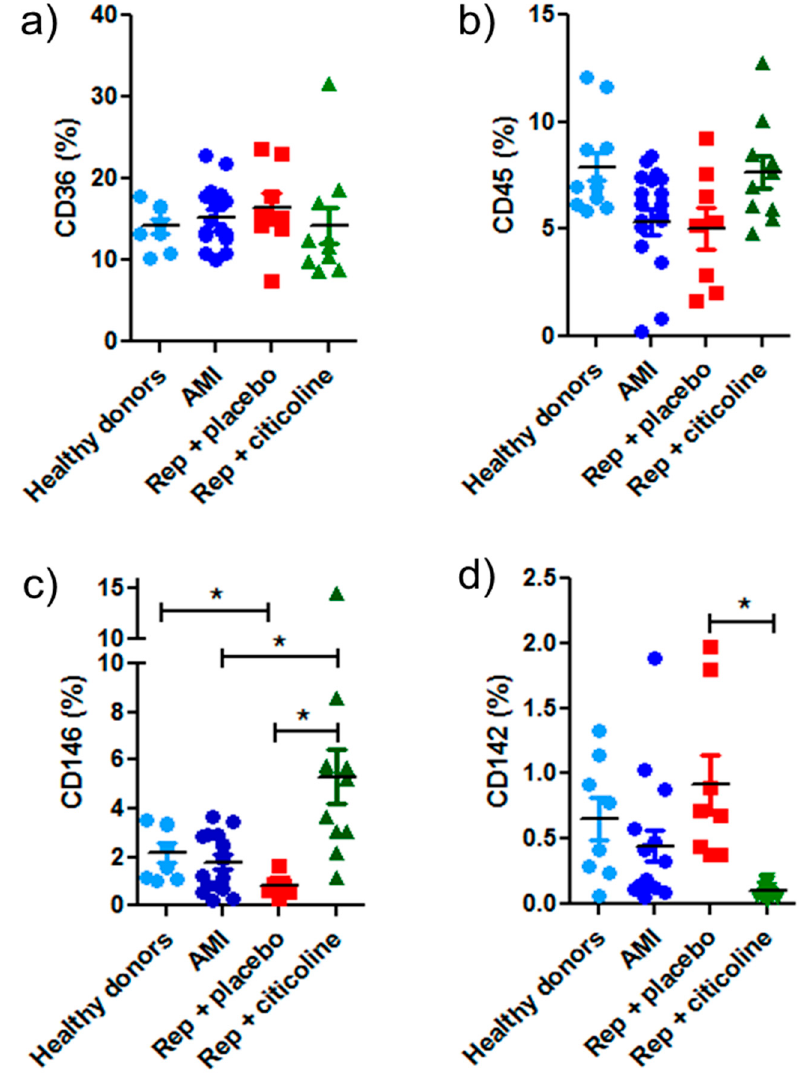
Figure 3. Flow cytometric analysis of exosomes obtained from plasma of AMI patients subjected to coronary angioplasty and treated with citicoline. Histograms showing mean fluorescence intensity of ( a ) CD36+, ( b ) CD45+, ( c ) CD146+, and ( d ) CD142+ antibodies in exosomes from healthy donors, from AMI patients, and from those subjected to angioplasty without (Rep + placebo) or with citicoline treatment. Data are expressed as mean ± SD of at least 10 exosome samples from different patients of each group. * p ≤ 0.05 .